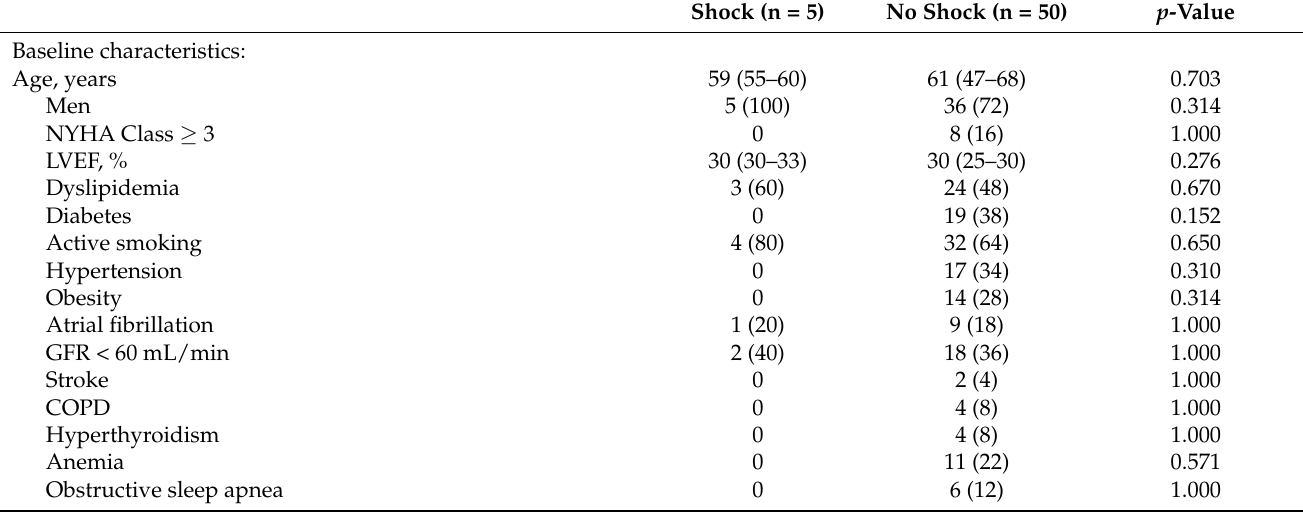
did not received an appropriate device-delivered electric